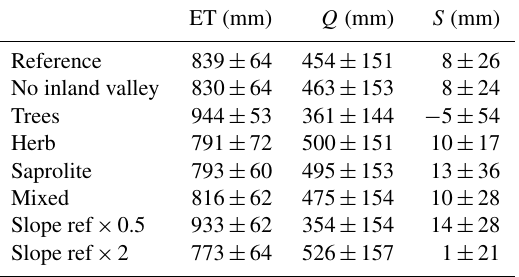
Table 6. Interannual mean and SD of simulated evapotranspiration (ET), streamflow ( Q ) and storage ( S ) for the different virtual exper- iments and for the period